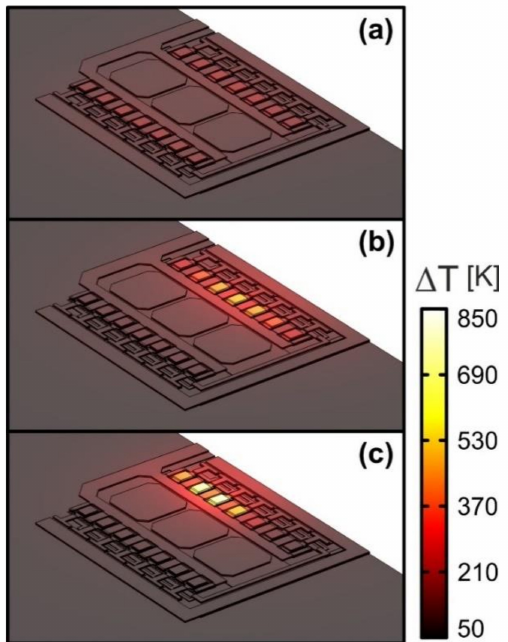
Figure 25. Spatial temperature rise map ∆ T ( x , y , z ) over half of the 28-cell array, as reconstructed by FANTASTIC equipped with the Kirchhoff’s transformation for I BTOT = 3.5 mA and V CE equal to ( a ) 6, ( b ) 10, and ( c ) 13.3